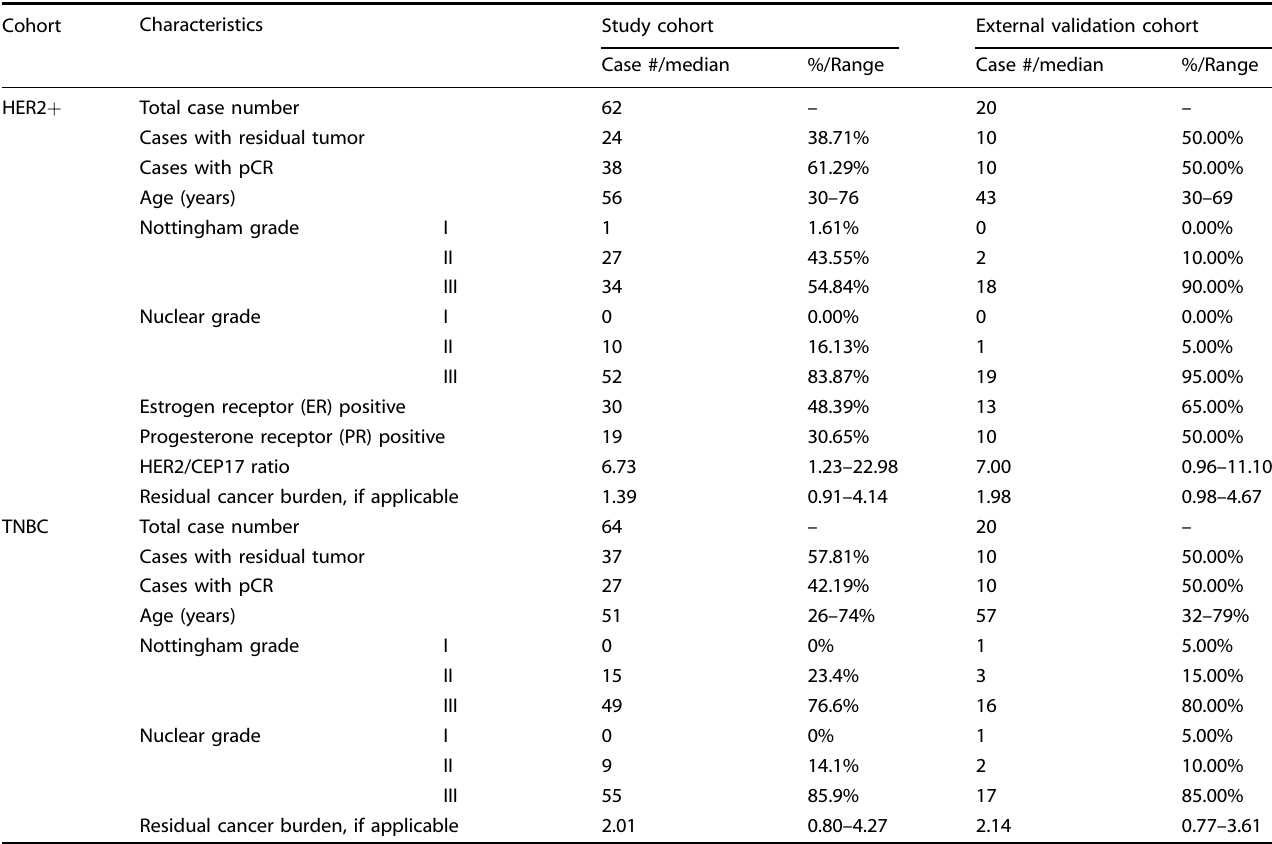
Table 1. Clinical and histopathological characteristics of HER2-positive and TNBC cases with neoadjuvant chemotherapy (NAC) in the study cohort and external validation